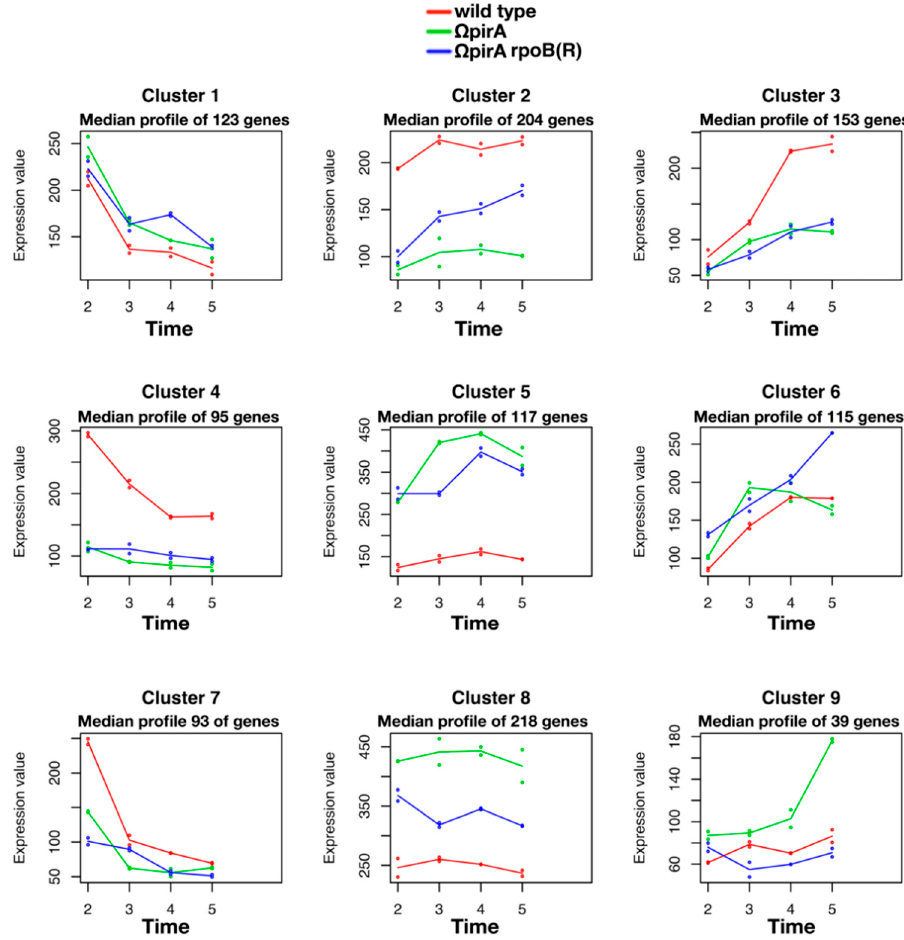
Figure 6. Time-course cluster analysis of RNAseq data in S. ambofaciens ATCC 23877 (w.t., red), and derivative Ω pirA (green), and Ω pirA rpoB(R) (blue) mutants. maSigPro identified the expression pattern of 1166 variable genes during the time course subdivided into 9 clusters (Supplementary Table S12) and median profile of each cluster was inferred from the expression patterns.